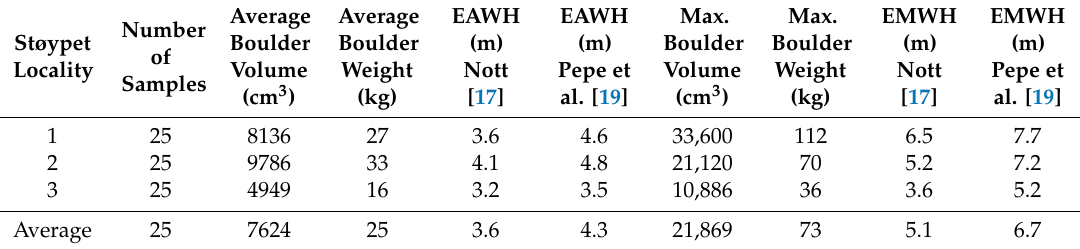
Table 1. Summary data from Appendix A (Tables A1–A3) showing maximum bolder size and estimated weight compared to the average values for sampled boulders from each of the transects together with calculated values for wave heights estimated as necessary for boulder-beach